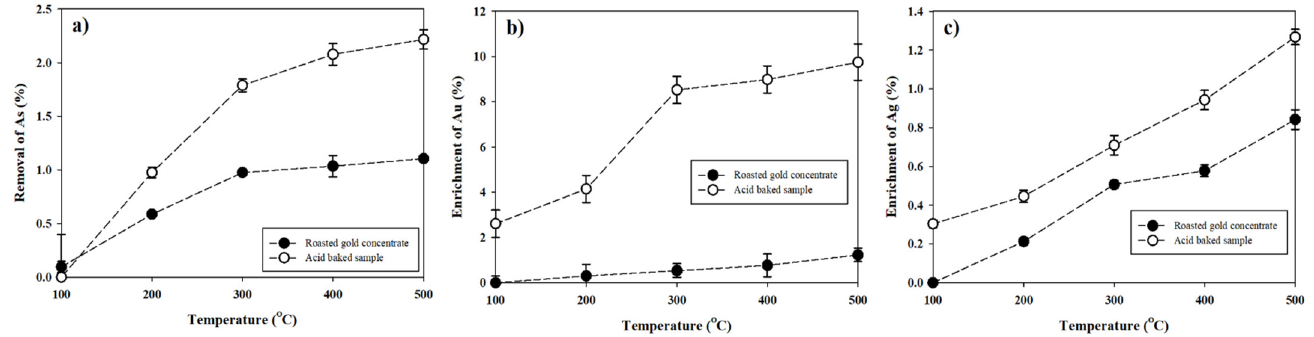
Figure 3. Effect of temperature on ( a ) removal of As, and ( b , c ) enrichment of Au and Ag.